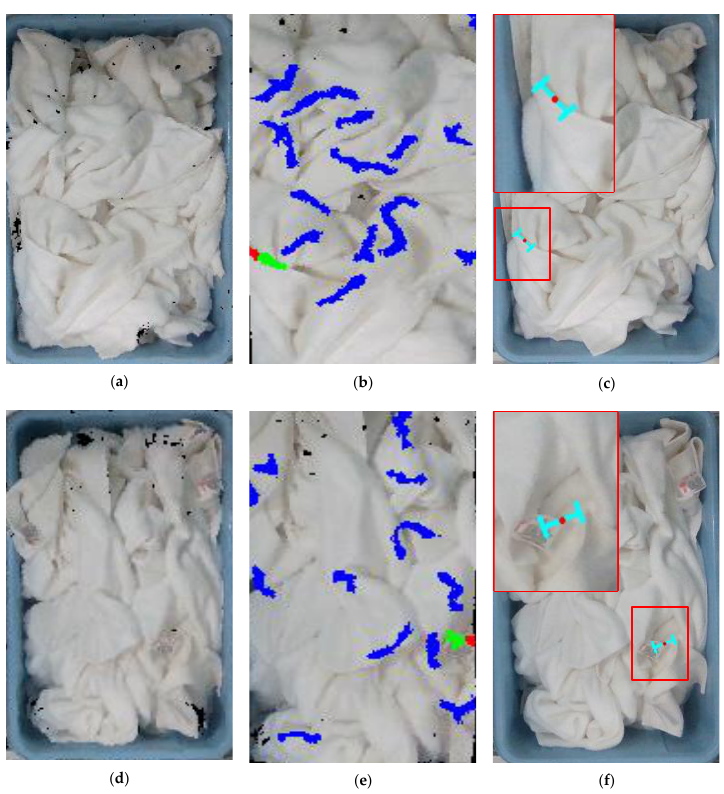
Figure 11. The examples of grasp failure: ( a ) the point clouds of the white towels; ( b ) the grasp point on the candidate convex wrinkle. ( c ) the projection of a grasp pose on the image, and the grasp pose is inappropriate; ( d ) the point clouds of the white towels; ( e ) the grasp point on the candidate convex wrinkle; ( f ) the projection of a grasp pose on the image, and the grasp point is in the trademark. As far as I know, selecting the highest point for grasping the clothes is also a common